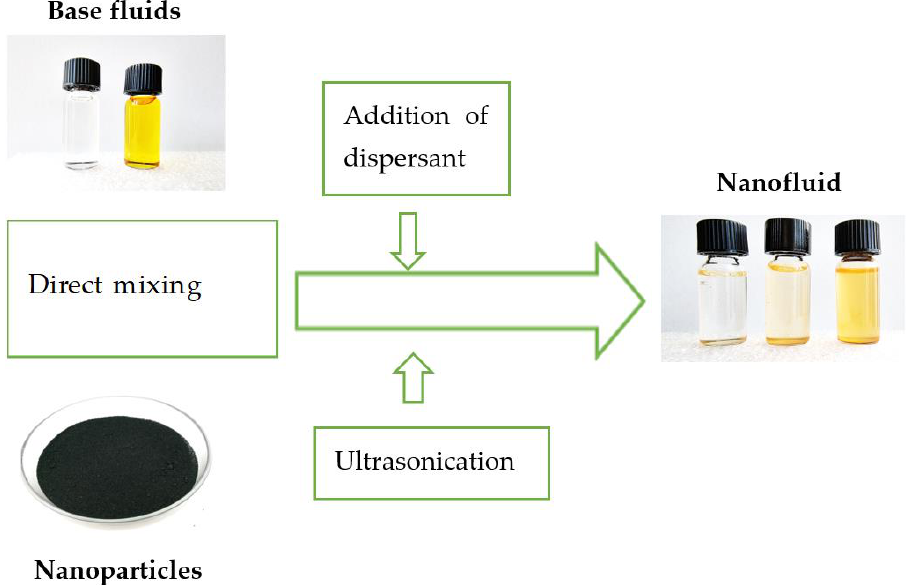
Figure 3. A simple illustration of the two-step method of preparing nanofluids. Inset photographs are from the authors archive.